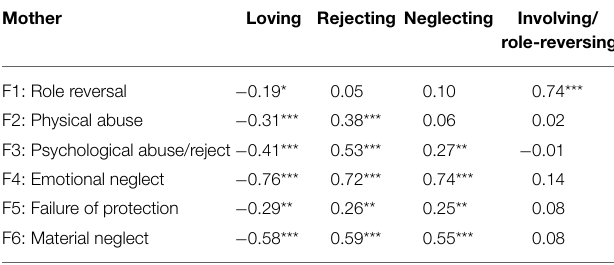
TABLE 4 | Correlations with AAI scales for inferred experiences with mother. Mother Loving Rejecting Neglecting Involving/